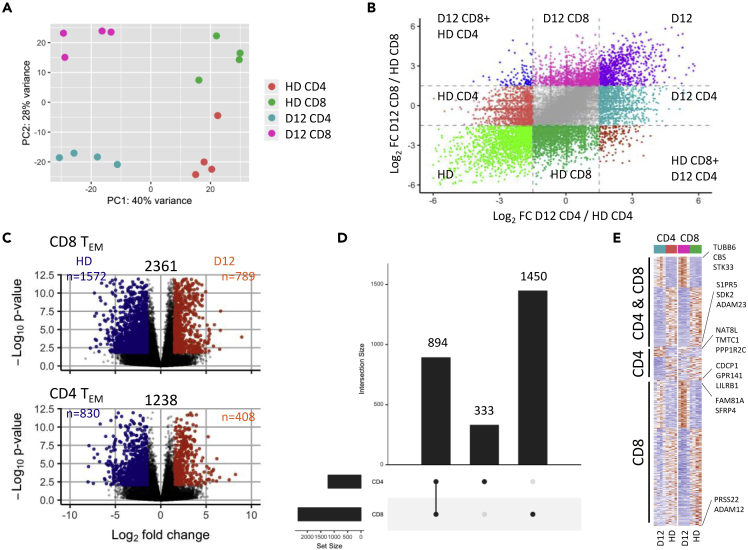
Transcriptional profiling of effector T cells during lymphopenia-induced proliferation(A) Transcriptomes of FACS-sorted CD45RA-CCR7- CD4 and CD8 effector T cells of healthy donor and day 12 post-autograft patients in reduced dimensional space. Principal component coordinates generated by principal component analysis on normalized gene count data from RNA sequencing.(B) Overview of gene-level transcriptional changes from calculated fold changes in gene expression at day 12 compared to HD for CD4 and CD8 effector T cells.(C) Differential expression analysis results from D12 vs HD comparisons of CD4 and CD8 cells. Colored points indicate differentially expressed genes in the comparison (Orange = UP at D12; Blue = DOWN at D12). Genes are deemed to differentially expressed if adjusted p value <0.05 and absolute log2FC > 1.5.(D and E) (D) Overlaps of differentially expressed genes between CD4 and CD8 cells (E) Gene expression profiles of differentially expressed genes from C. Color indicates standard deviation from mean (red = increase at D12; blue = decrease at D12). Genes are grouped into those identified as differentially expressed between D12 and HD samples in both CD4 and CD8, CD4-only or CD8-only effector T cells. The top three UP/DN differentially expressed genes in each group (ordered by fold change) are labeled.